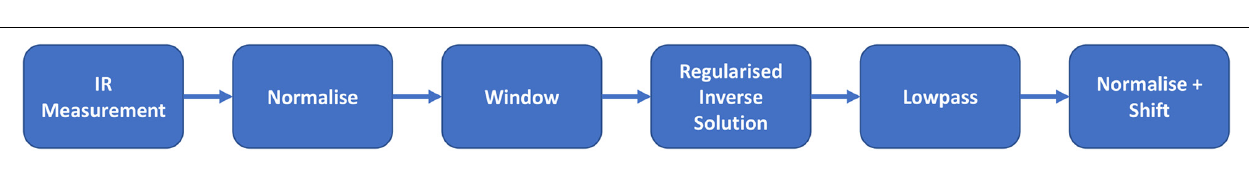
FIGURE 3 | Block diagram showing the inverse filter design